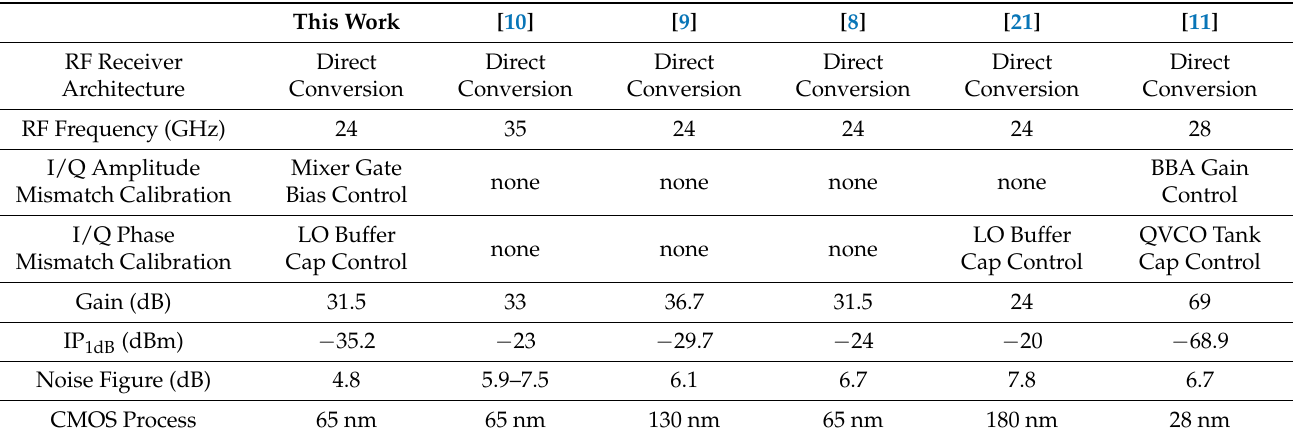
Table 1. Performance summary and